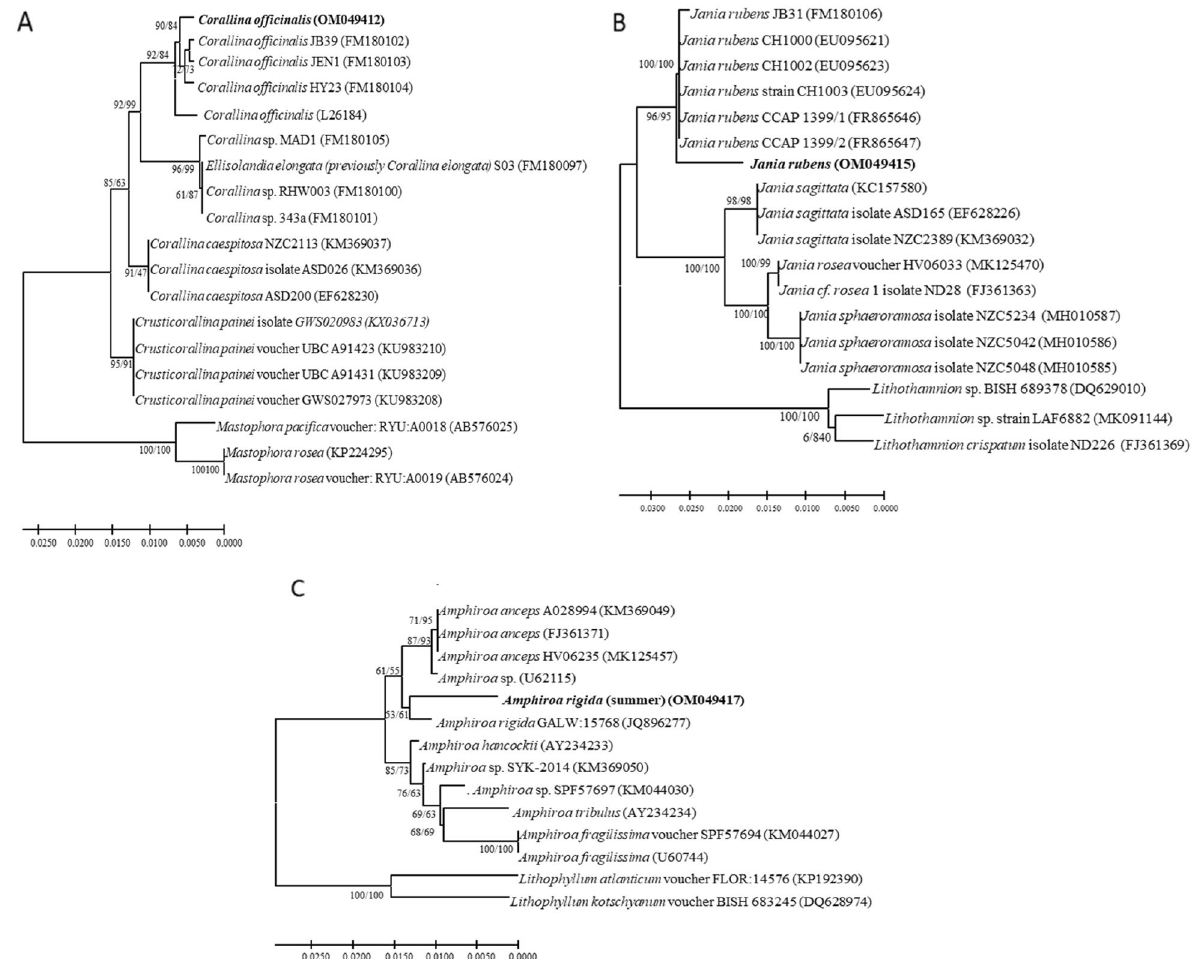
Fig. 10 Maximum Likelihood (ML) dendrogram showing calcareous red species in different seasons based on 18S nucleotide sequences. Bootstrap values greater than 70 are shown on both trees in order of Maximum Likelihood bootstrap (left) and Maximum Parsimony (MP) (right). The identified species in this study were marked in bold. Distance scale was shown below each